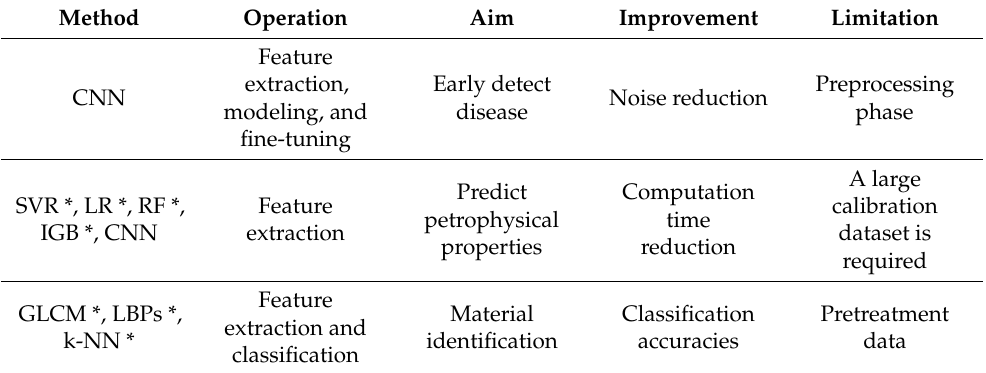
Table 1. Three examples of Machine Learning and Deep Learning techniques applied in X-ray